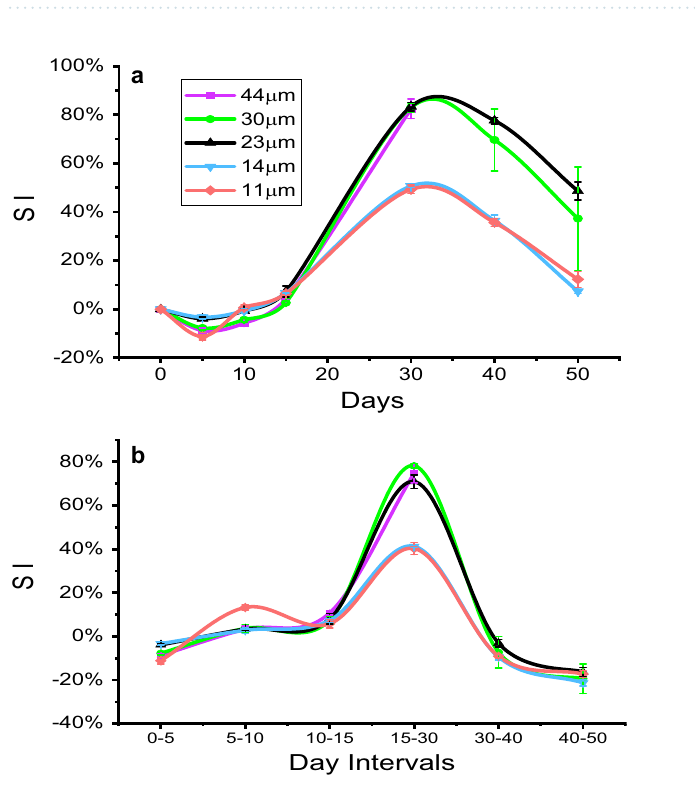
Figure 7. Swelling kinetics. ( a ) Complete swelling index (SI) changes from day 0. ( b ) Swelling changes between each incubation time